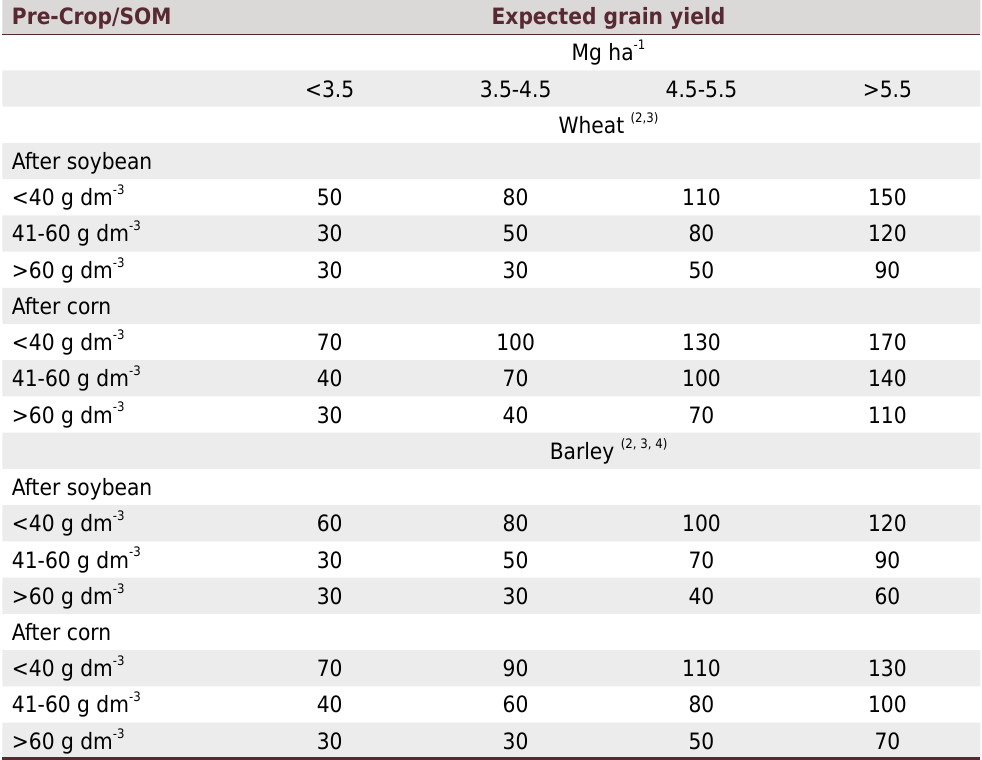
Table 4. Indicated urea-N rates for crescent yield expectations of wheat and barley cultivated in soils with different soil organic matter contents and preceding summer crops (corn or soybean) in the South-Central region of Paraná